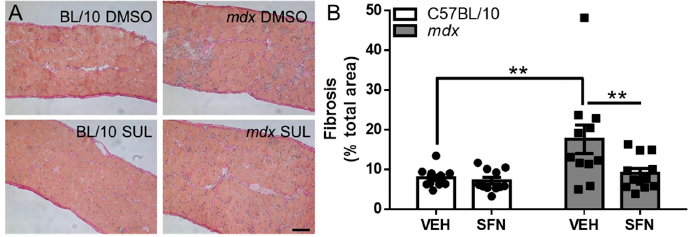
Figure 4. Oral SFN administration reduces fibrosis in the diaphragm of mdx mice. Four-week-old male C57BL/10 and mdx mice received either vehicle (2% DMSO/corn oil; VEH) or SFN (2 mg/kg in 2% DMSO/corn oil; SFN) via daily oral gavage for five days a week for four weeks. Diaphragm muscle fibrosis ( A ) was quantified ( B ) at the conclusion of treatment. n = 11–12/group. Scale bar = 100 µ M. Statistical analysis was performed using a two-way ANOVA with a Bonferroni’s post-hoc test to assess effects of treatment. ** p <